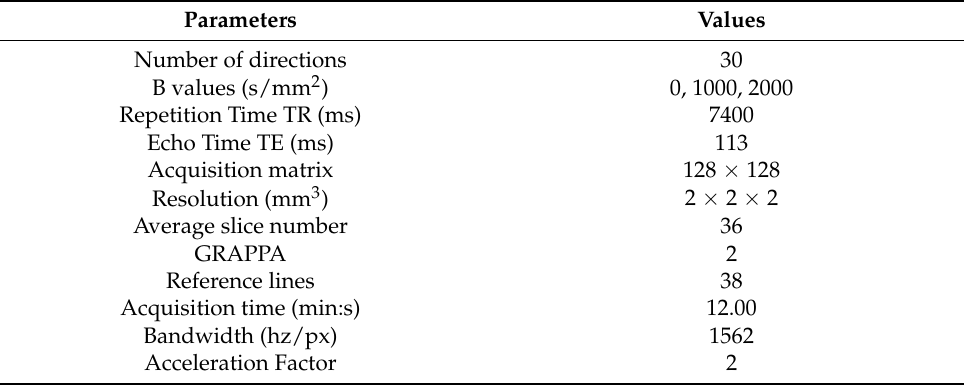
Table 2. SMS diffusion sequence acquisition parameters.